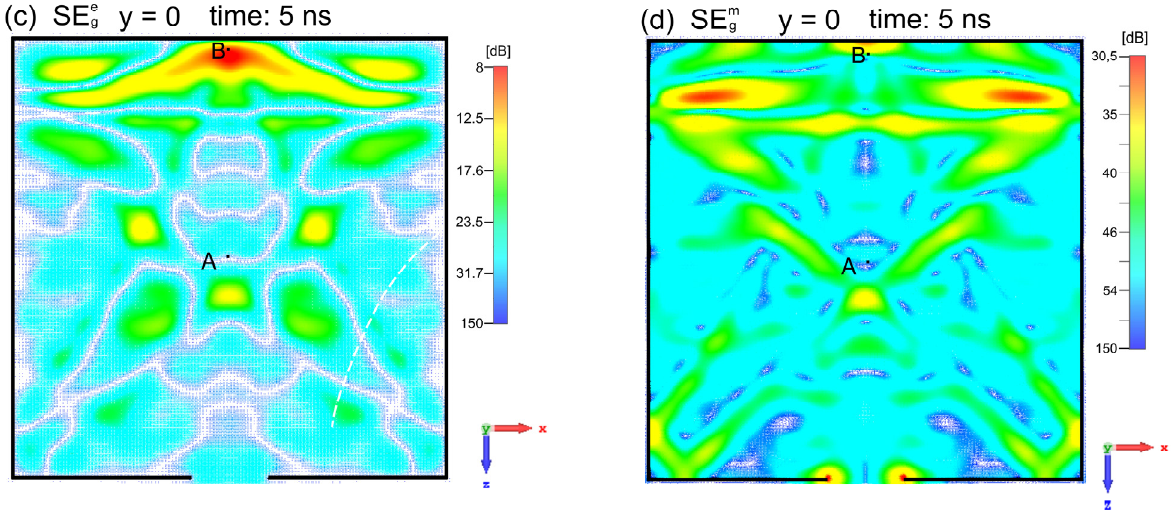
Figure 13. Global SE g maps of the shielding effectiveness (the electric SE e g and magnetic SE m g ) at times t = 1.7 ns and t = 5 ns in the plane y = 0. The case of the interference phase.